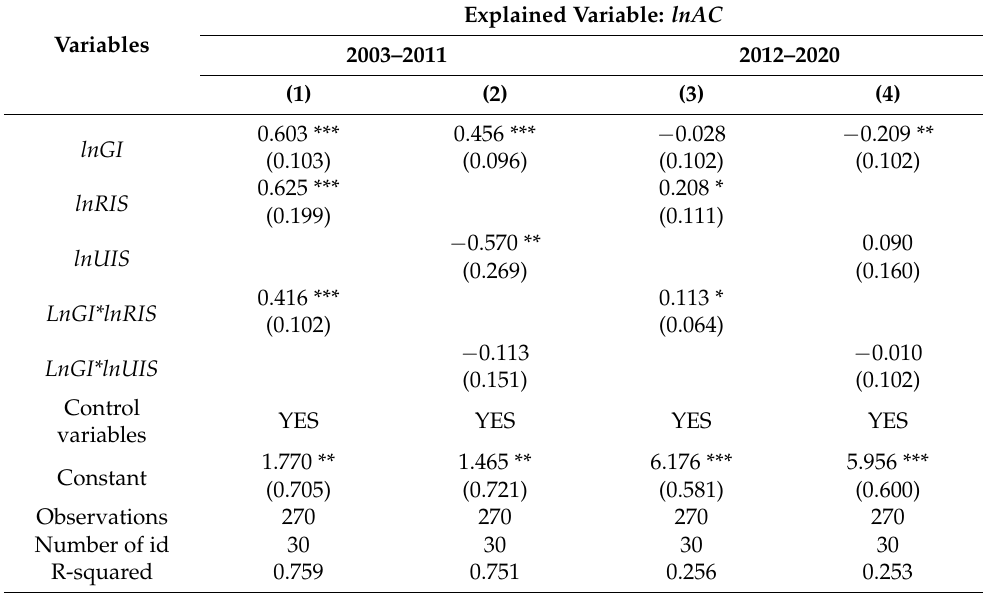
Table 7. Regression results of time